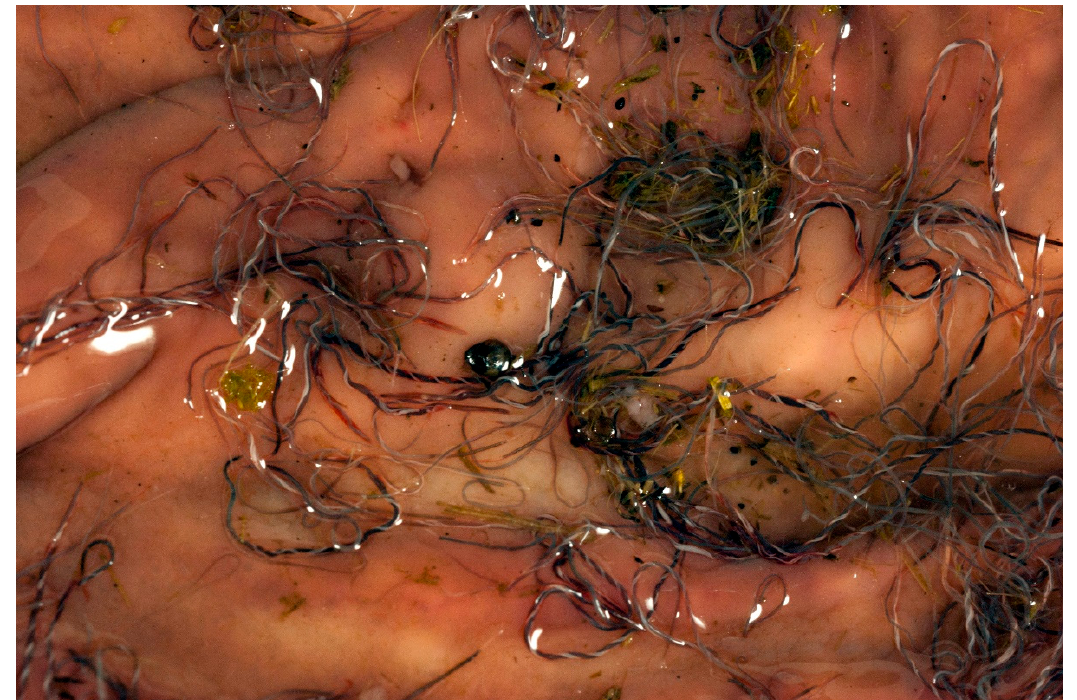
Figure 2. Haemonchus contortus parasites in the abomasum of an affected lamb, demonstrating the characteristic red and white twisted “barber’s pole” appearance. Image courtesy of Professor K G Thompson, Massey University, New Zealand.